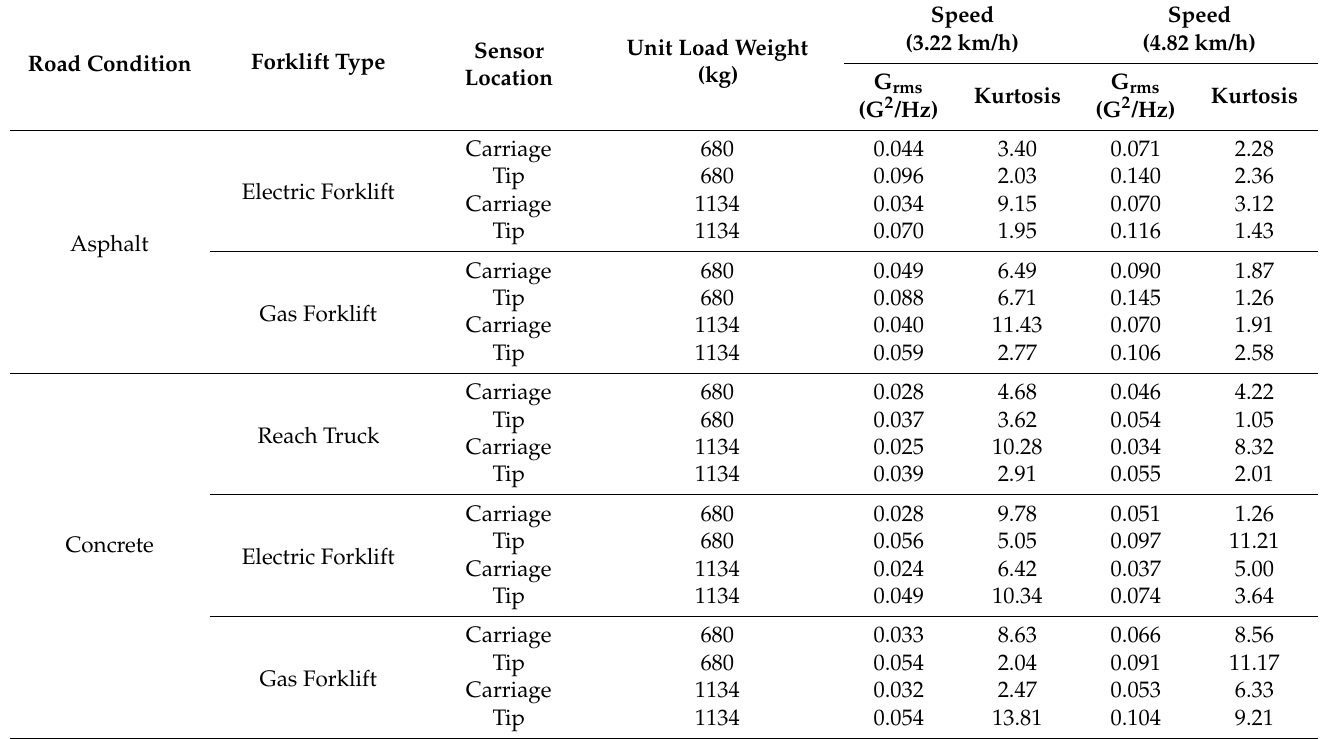
Table 1. Overall G rms (G 2 /Hz) and kurtosis values for distributions of recorded events obtained for this study.